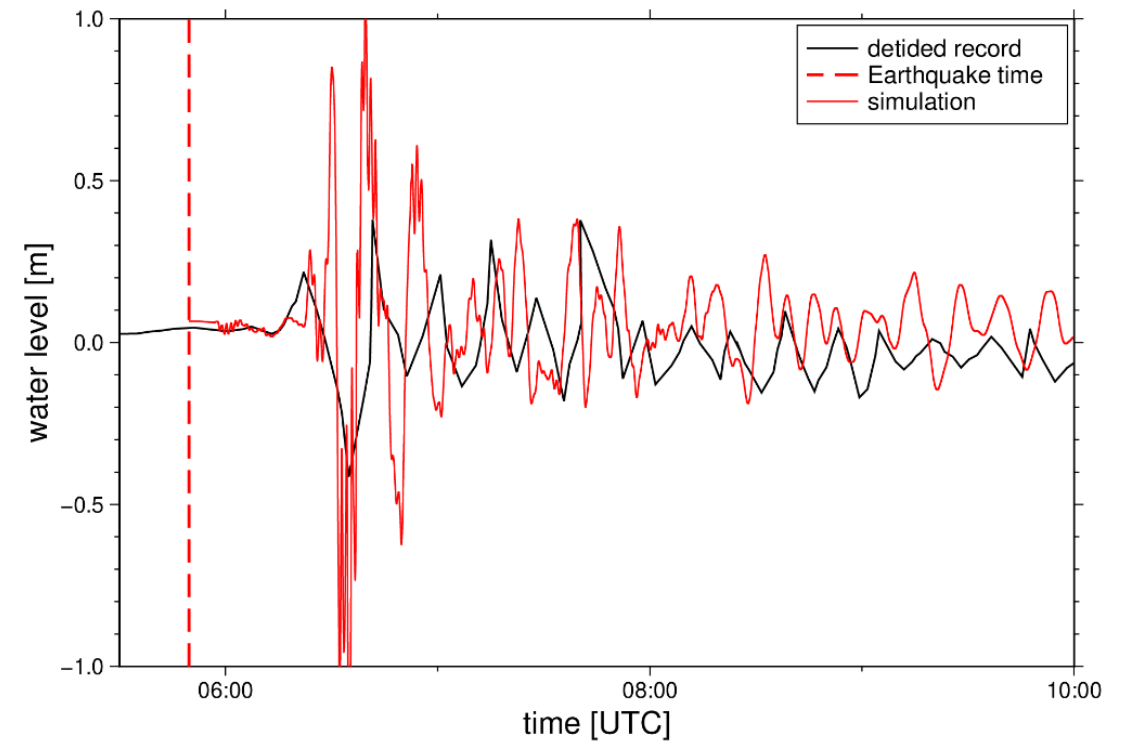
Figure 5. Detided water level recorded in Apia (black line) and simulated (red line). Earthquake time is also given.